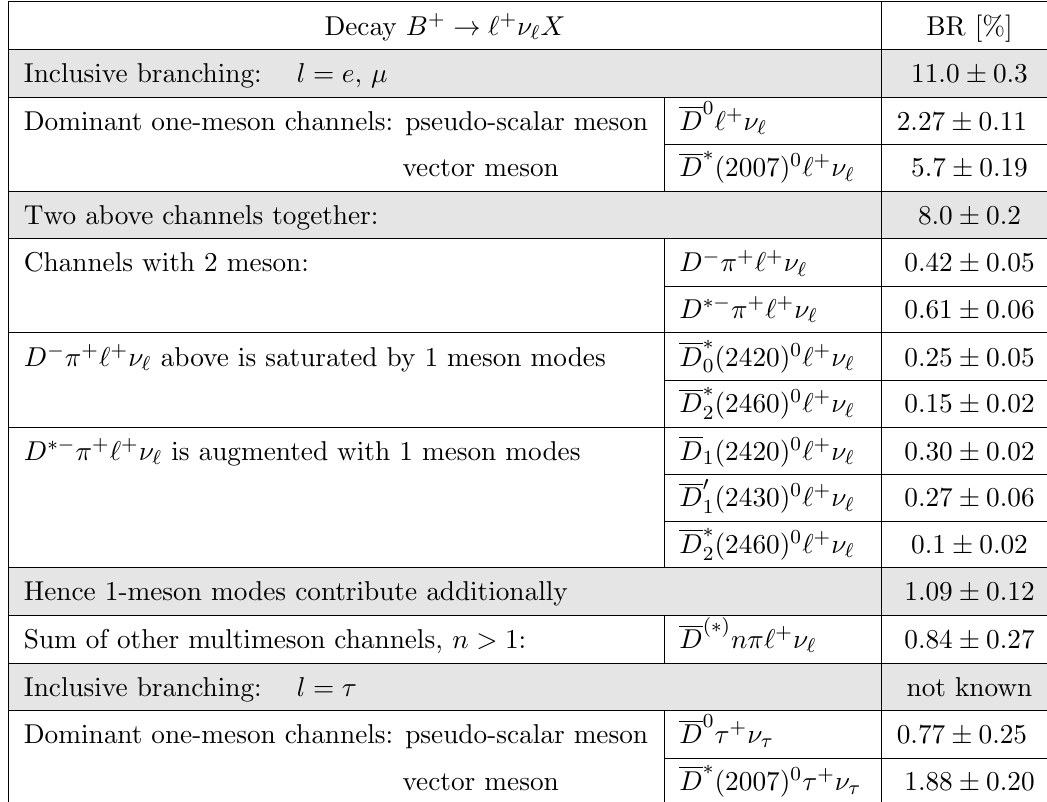
To estimate relative relevance of single and multi-meson decay channels, we (cid:12)rst con- sider the branching ratios of the semileptonic decays of B + and B 0 (with ordinary (mass- less) neutrino (cid:23) ‘ in the (cid:12)nal